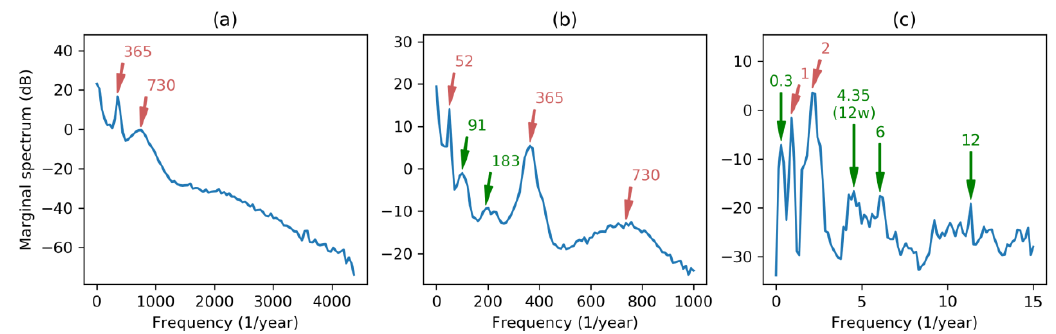
12 of 25 Figure 12. Electricity demand Discrete Hilbert – Huang Transform at different frequency scales: ( a ) Very high; ( b ) high; ( c ) medium high; ( d ) medium low; ( e ) low; ( f ) very low. If the electricity demand can be considered stationary, or if we are not interested in its transient behavior, the temporal axis of DHHS can be squeezed to obtain the Marginal Hilbert – Huang